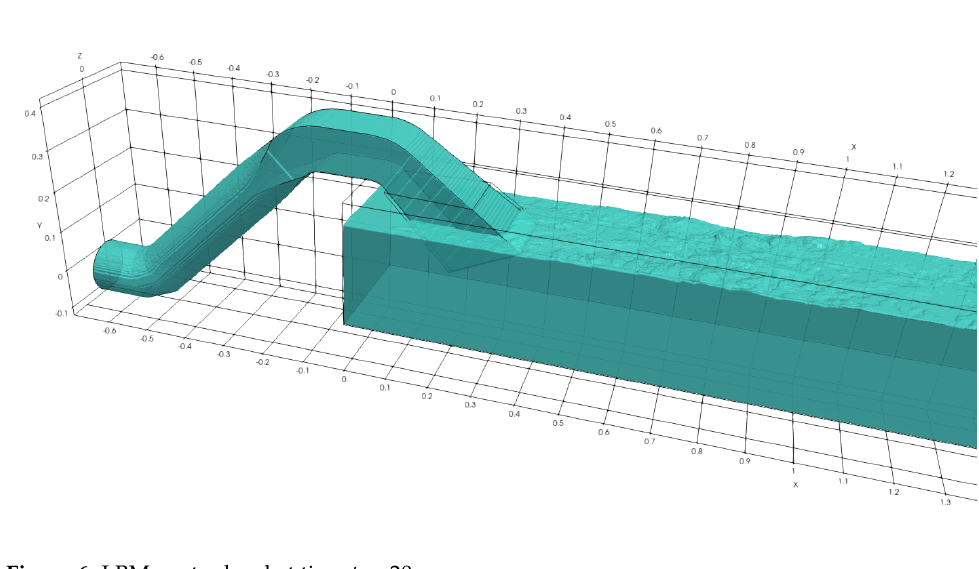
Figure 6. LBM, water level at time t = 20s.